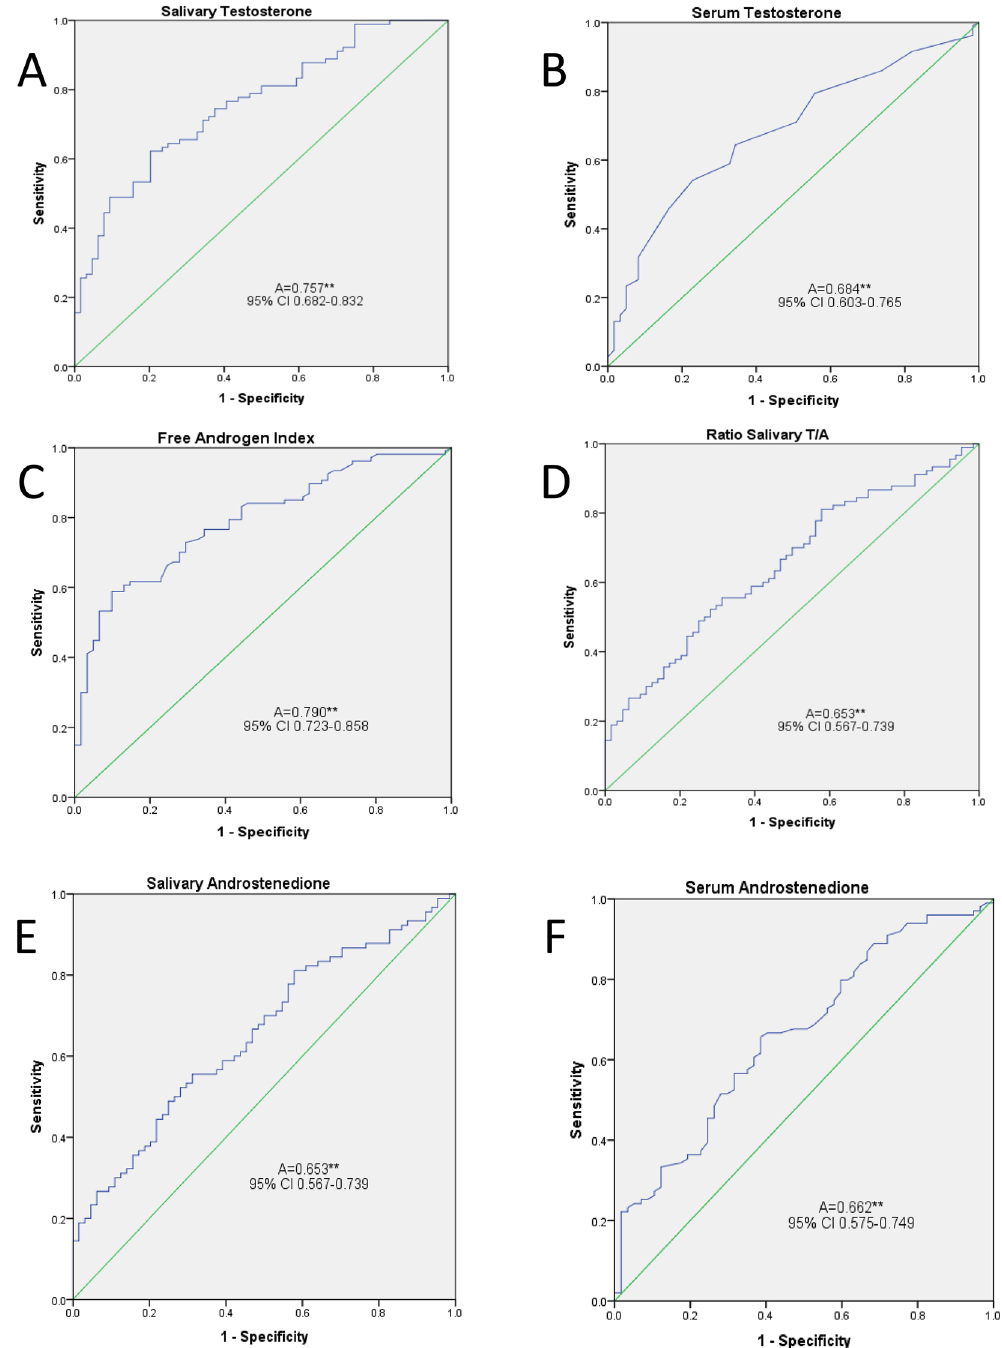
Figure 1. Receiver operating curves for salivary and serum androgens. Receiver operator curves for ( A ). Salivary testosterone, ( B ). Serum testosterone, ( C ). Free androgen index (FAI), ( D ). Salivary testosterone/ salivary androstenedione ratio, ( E ). Salivary androstenedione, ( F ) Serum androstenedione. These show that FAI, salivary testosterone and (less so) serum testosterone were “good” predictors of a diagnosis of PCOS, whilst the salivary testosterone/salivary androstenedione ratio, salivary androstenedione and serum androstenedione were “fair” predictors of a diagnosis of